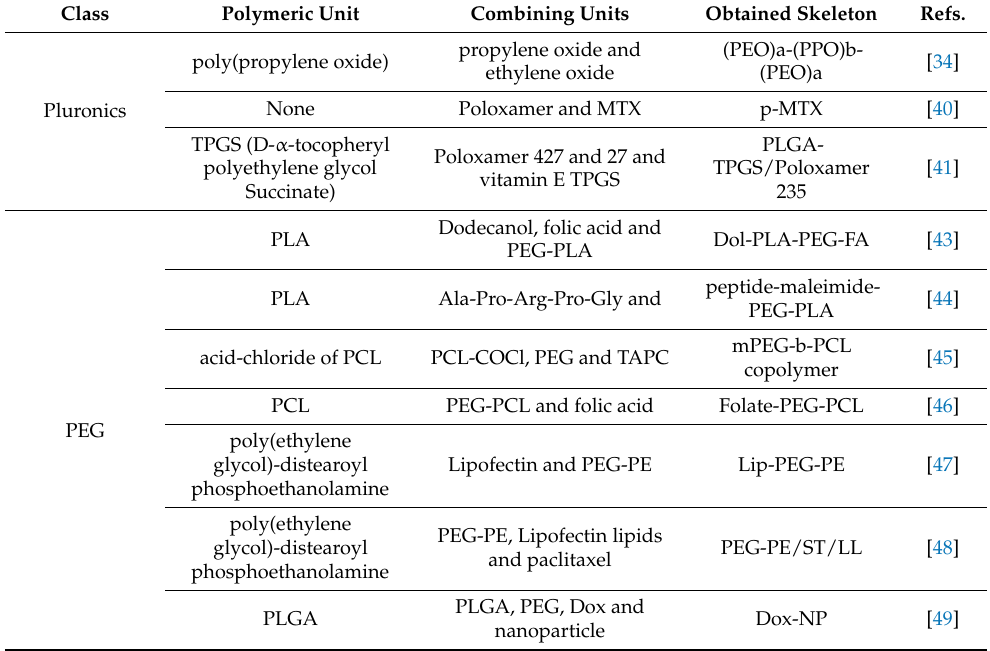
Table 1. The micelle ‐ based materials act as nanocarriers.